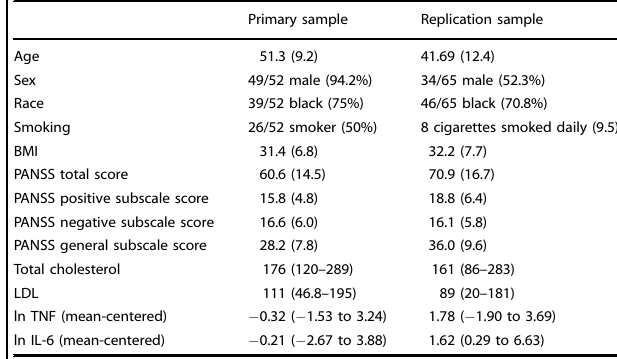
Table 1. Sociodemographic and clinical variables as well as immune and metabolic marker concentrations in the primary sample ( n = 52 patients) and the replication sample ( n = 65).